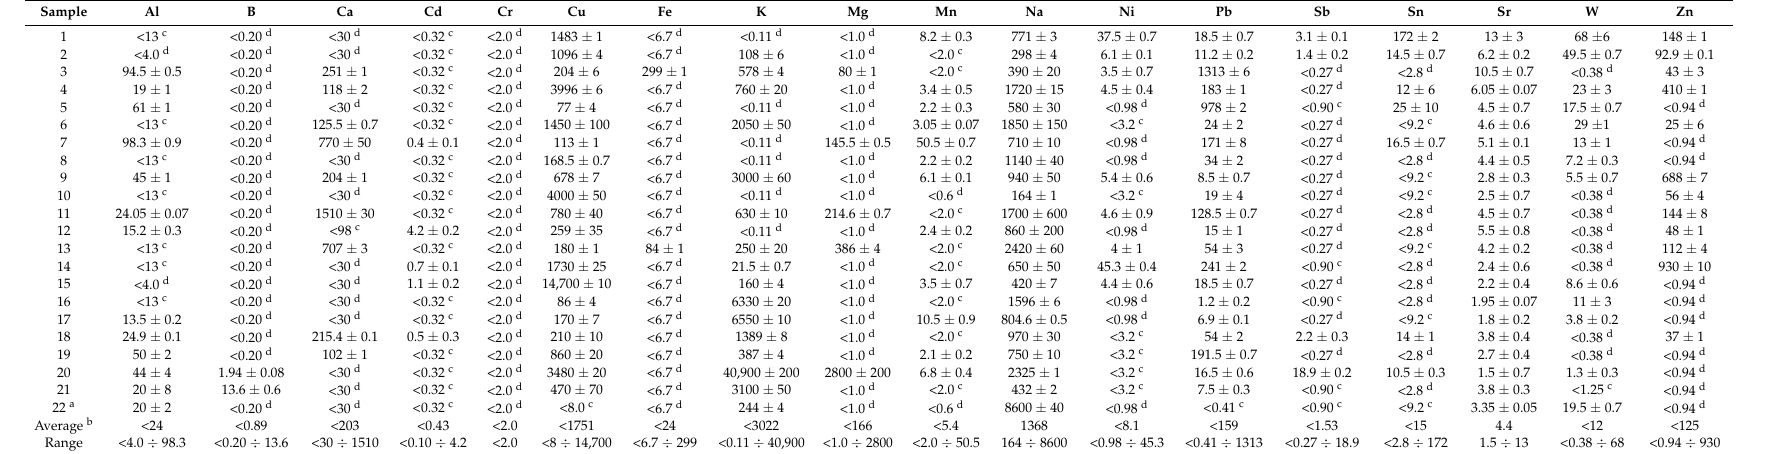
Table 7. Selected elemental abundances in Filuferru samples from Sardinia,